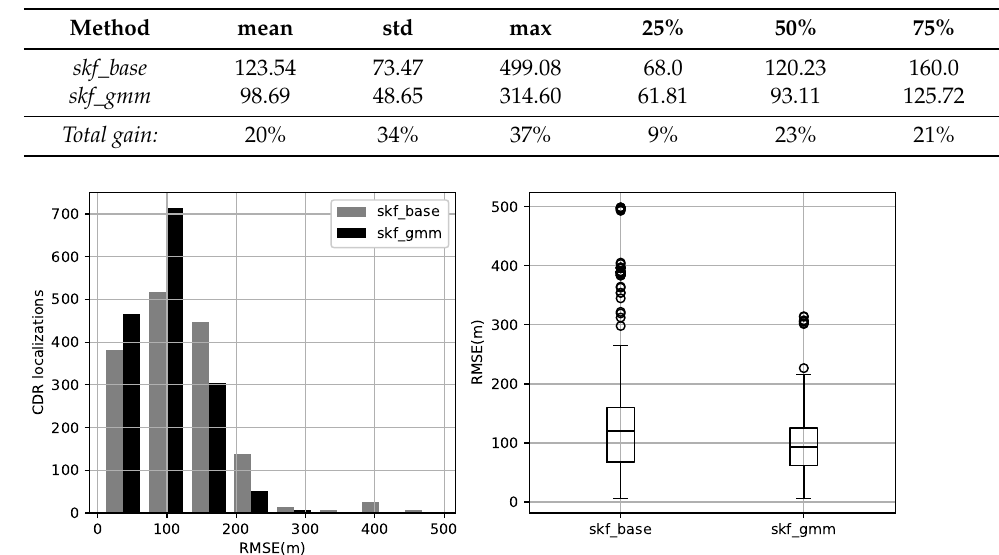
Table 2. Root-mean-square error (meters) of localization methods skf_base original coverage estimation method compared to skf_gmm proposed method.